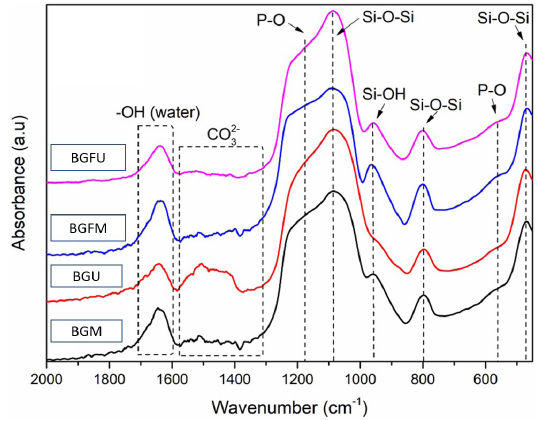
Figure 4. FTIR spectra of BGM, BGU, BGFM and BGFU samples.